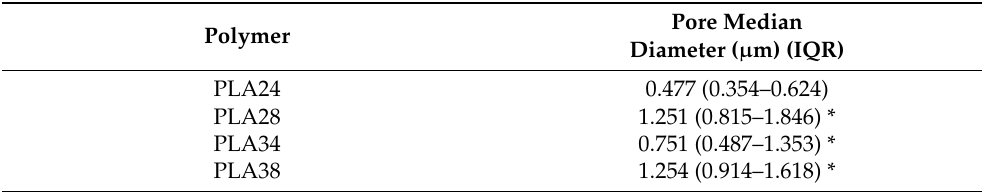
Table 2. Pore median diameter of PLA implanted subcutaneously in one horse and removed at different times.